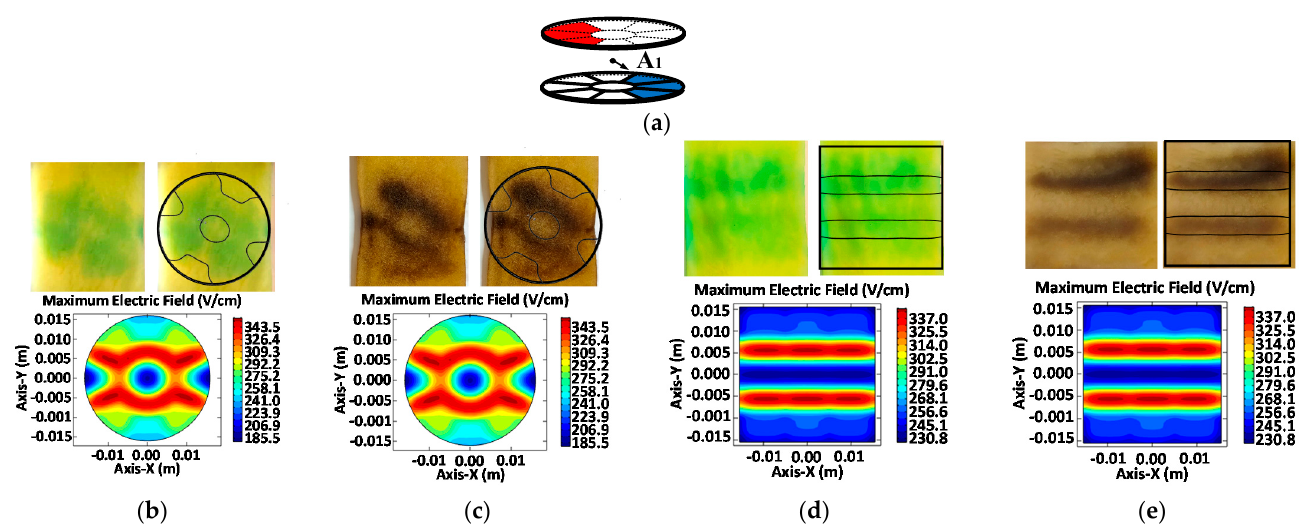
Figure 9. Results of the application in plant tissue of a single CS: ( a ) applied CS, ( b ) photo of the dyed potato and simulated electric field, using circular electrode, ( c ) photo of the degraded potato and simulated electric field, using circular electrode, ( d ) photo of the dyed potato and simulated electric field, using square electrode, and ( e ) photo of the degraded potato and simulated electric field, using square electrode.